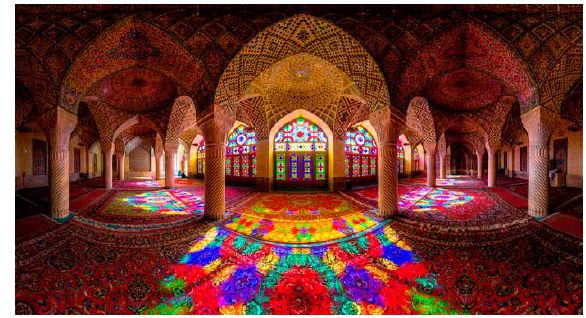
fig. 10. nasiralmolk West Shabestan (photo by Mohammad reza Domiri Ganji)